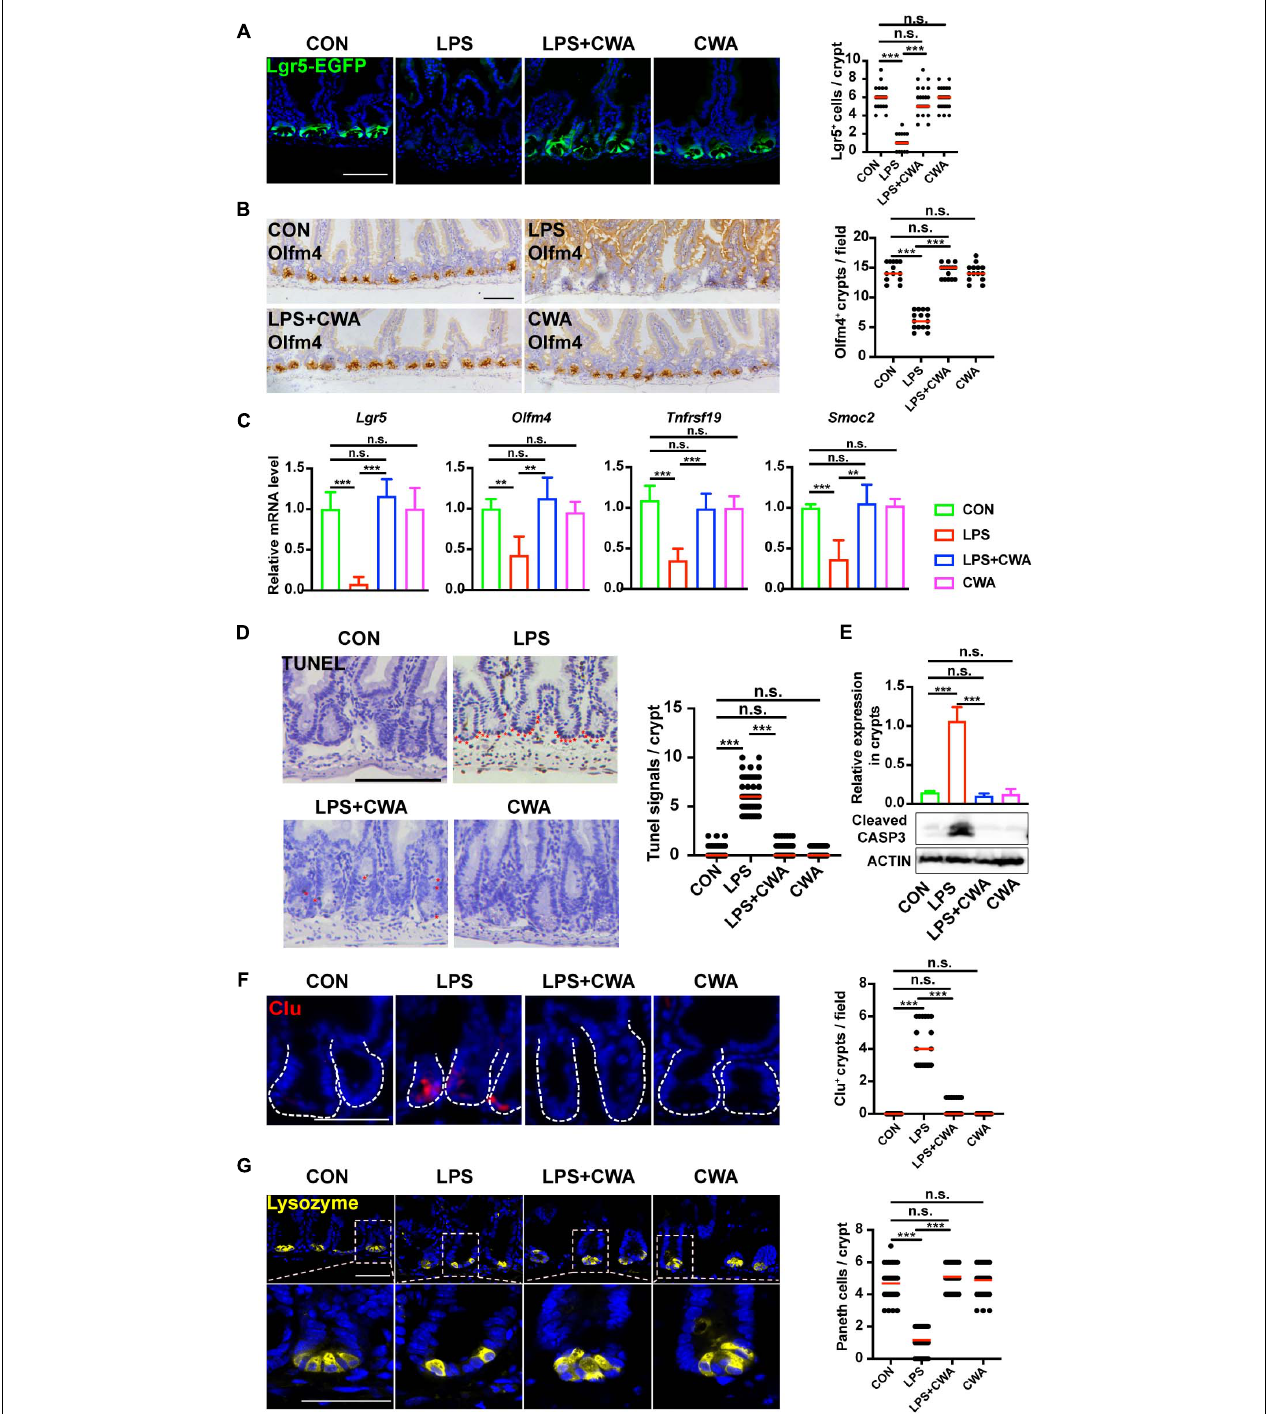
FIGURE 3 | CWA protects Lgr5 + ISCs from LPS-induced ablation. (A) Representative confocal microscopy images of EGFP positive cells and numbers of Lgr5 positive cells per crypt. Scale bars, 100 µ m. (B) IHC analysis of ISCs marker Olfm4 expression in jejunum crypts and quantification of the Olfm4 positive crypts. Scale bars, 100 µ m. (C) Quantitative RT-qPCR analysis of Lgr5 , Olfm4 , Tnfrsf19 , and Smoc2 expression in intestinal crypts (D) Representative images of TUNEL assay. Red stars indicate apoptotic stem cells and number of TUNEL + cells in crypts. Scale bars, 100 µ m. (E) Western blot analysis of Cleaved Caspase-3 expression in small intestinal crypts. (F) Representative immunofluorescence images of Clu expression in crypt and quantification of the Clu positive crypts. Scale bars, 100 µ m. (D) Representative confocal images of Paneth cells (Lyz+) in SI crypts and quantification of Paneth cells in each crypt. Scale bars, 50 µ m. ** p < 0.01, *** P < 0.001 by two-sided, unpaired t -test. All data represent at least three independent experiments.